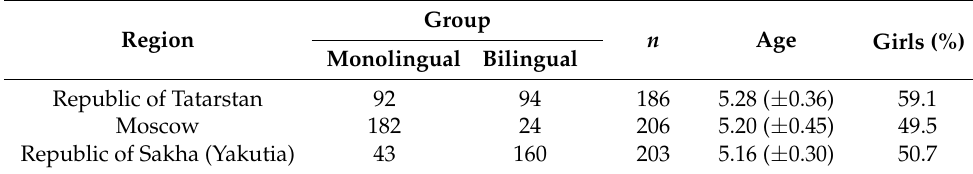
Table 1. Bilingual and monolingual children in the final